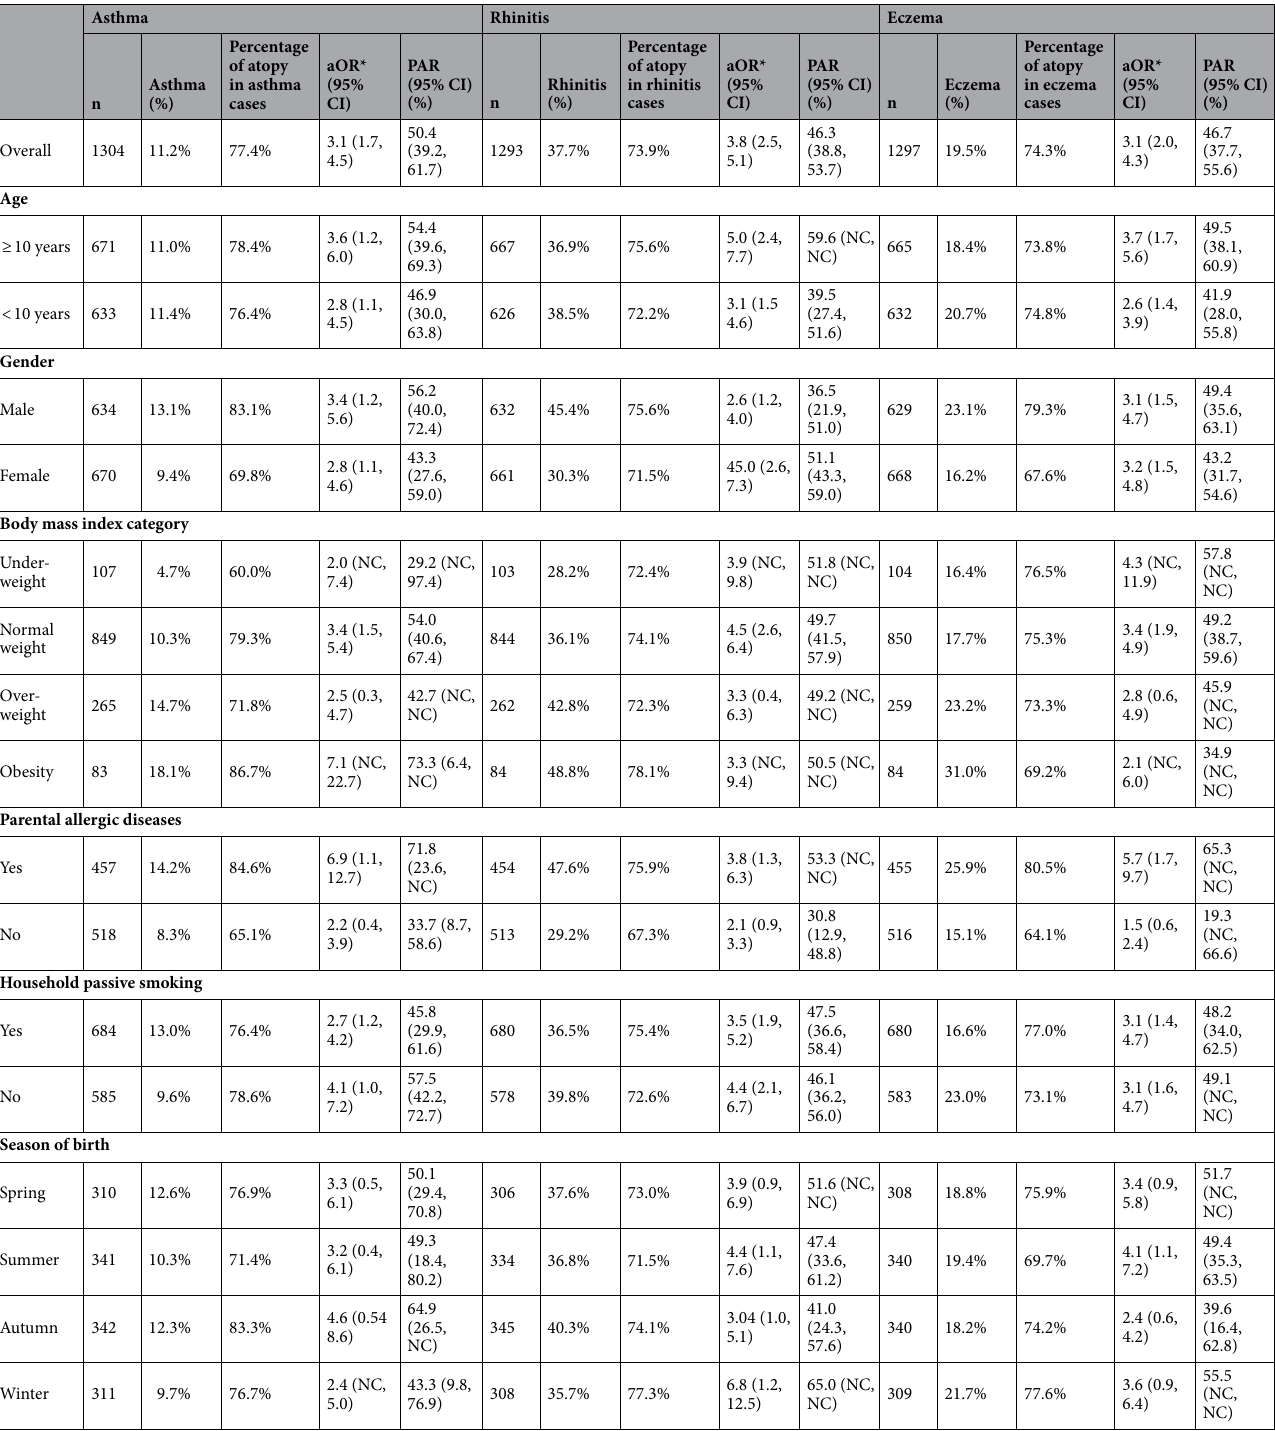
Table 2. Percentage of allergic diseases attributable to atopy. aOR adjusted odds ratio, CI confidence interval, PAR population attributable risk, NC not computed. *Adjusted for age, gender, body mass index, household passive smoking, and season of